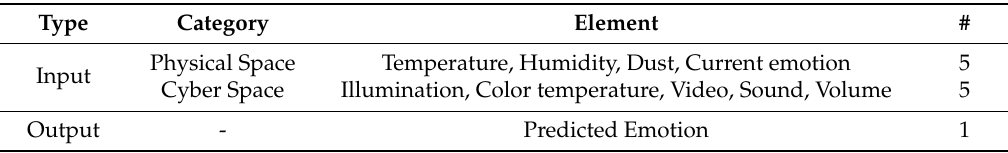
Table 7. Input and output of emotion prediction model.